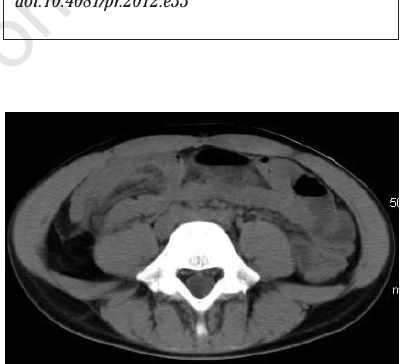
Figure 1. Abdominal computed tomogra- phy showing the ensheathing of one por- tion of the colon into another.